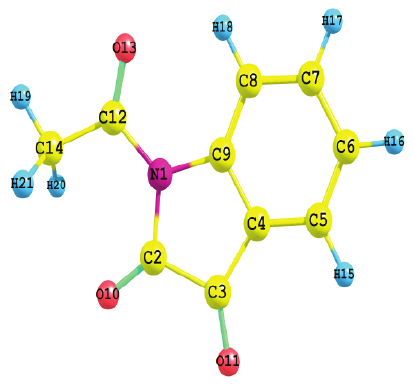
Figure 2: Molecular structure of N -acetylisatin along with numbering of atoms.